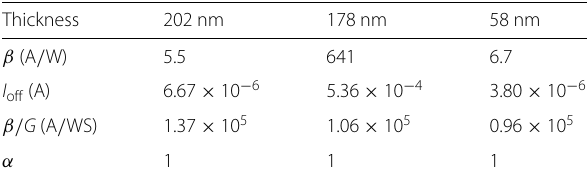
Table 1 Fitting parameters in Sb 2 Se 2 Te nanosheets